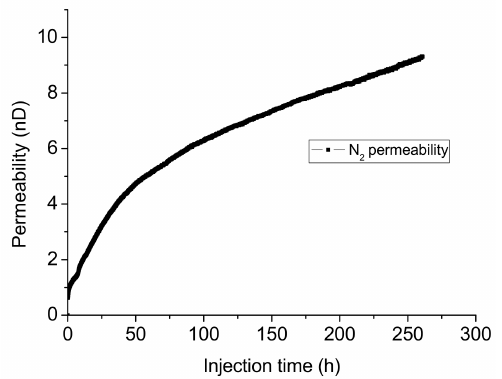
Figure 9. Evolution of calculated permeability to N 2 with time after water flooding.